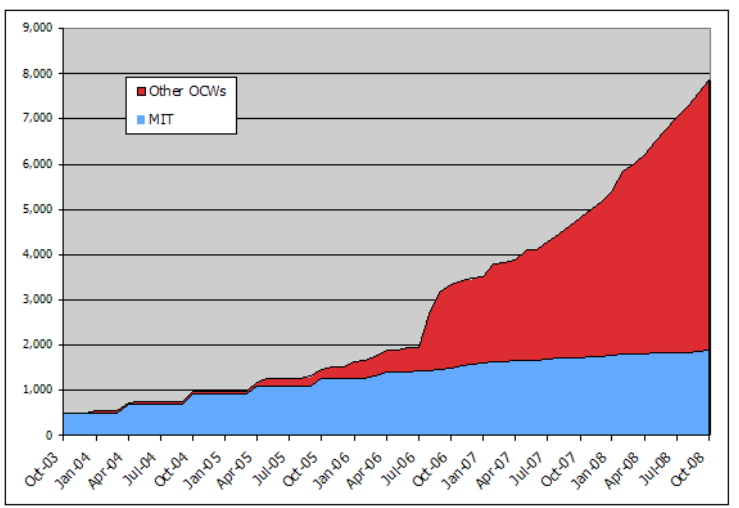
Figure 2 . Open courseware production in the Open Courseware Consortium (Caulfield, 2008; used with